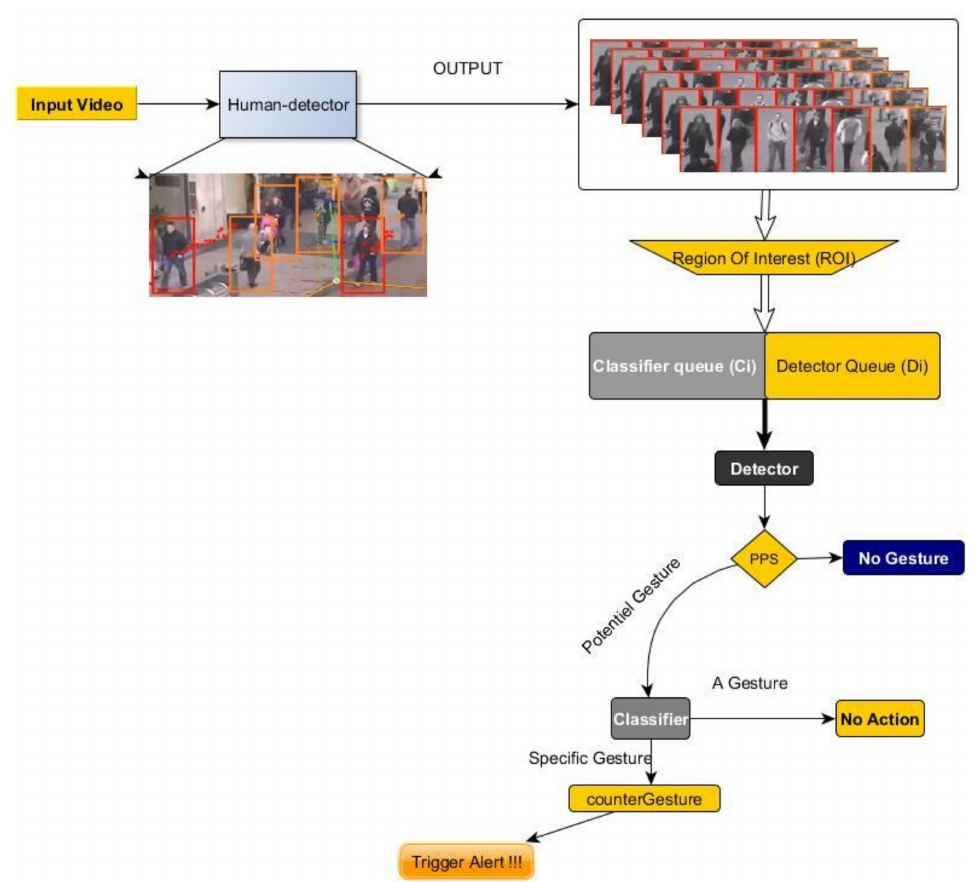
Figure 5. A video is submitted to a module called the human detector, which extracts images containing a human. These frames are processed using scrolling sliding windows in which the detection queue is placed at the very beginning of the classifier assignment queue. If the detector recognizes an action / gesture, the classifier is activated via the Post Processing Service (PPS) [44] and, if it corresponds to one of the gestures contained in our specific set, the alert is